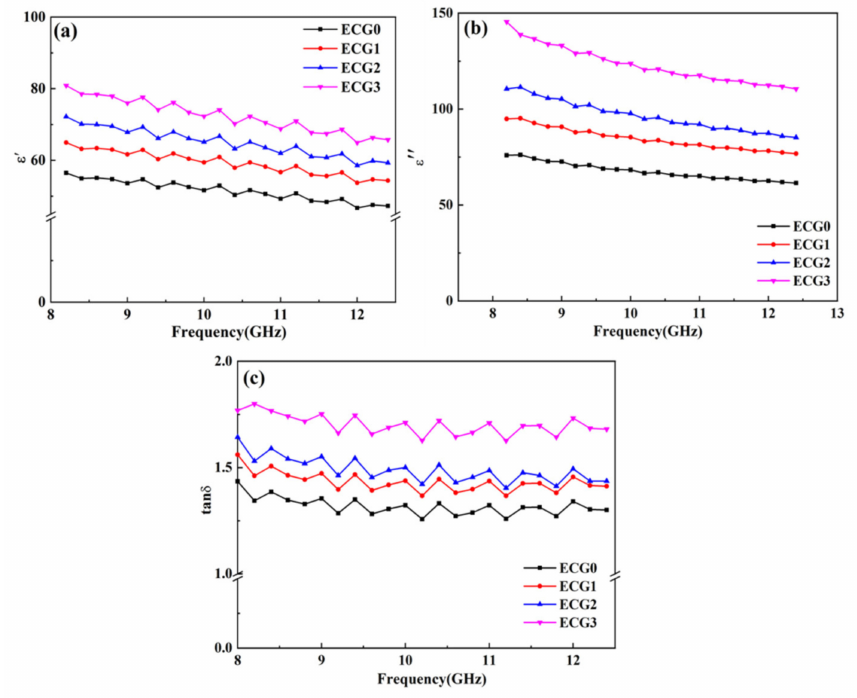
Figure 7. ( a ) ε ’, ( b ) ε ” and ( c ) tan δ ε of CNT/GNP/EUG